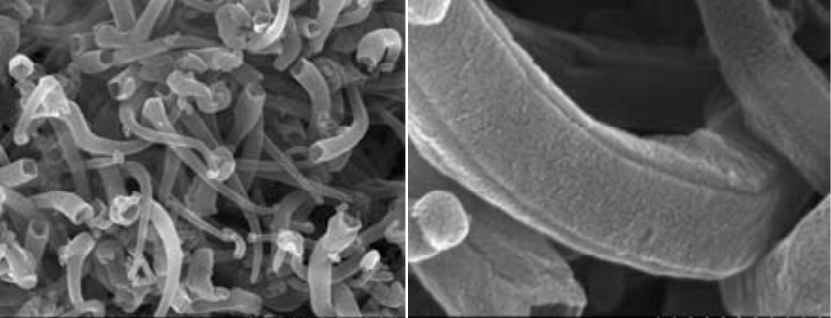
Figure 5. SEM images showing morphology of quadrangular carbon nanotubes. Republished with permission from the Royal Society of Chemistry, from [89]; permission conveyed through Copyright Clearance Center, Inc. (Danvers, MA,